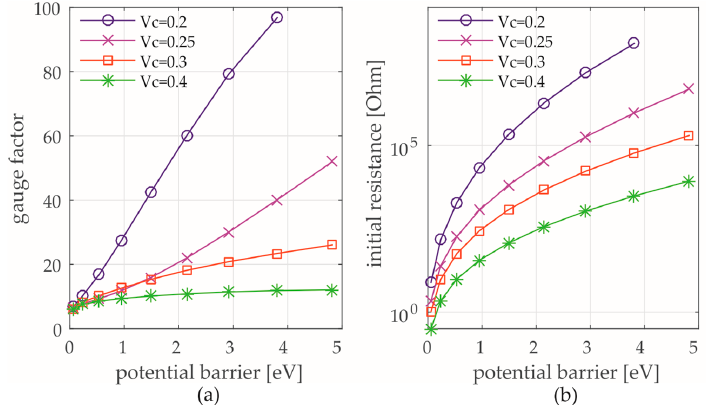
Figure 10. GF ( a ) and the initial resistance ( b ) as a function of the potential barrier.